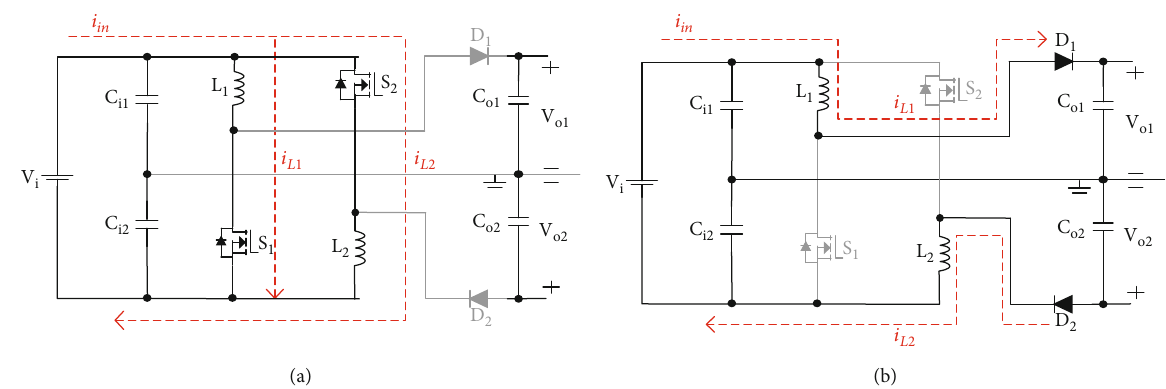
Figure 4: The equivalent circuit in CCM operation: (a) mode 1 and (b) mode 2.